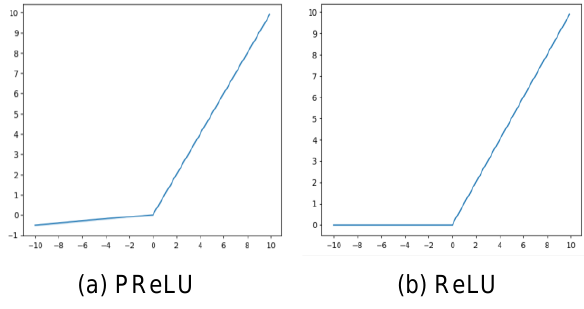
Figure 6. PReLU(a) and ReLU(b) action function